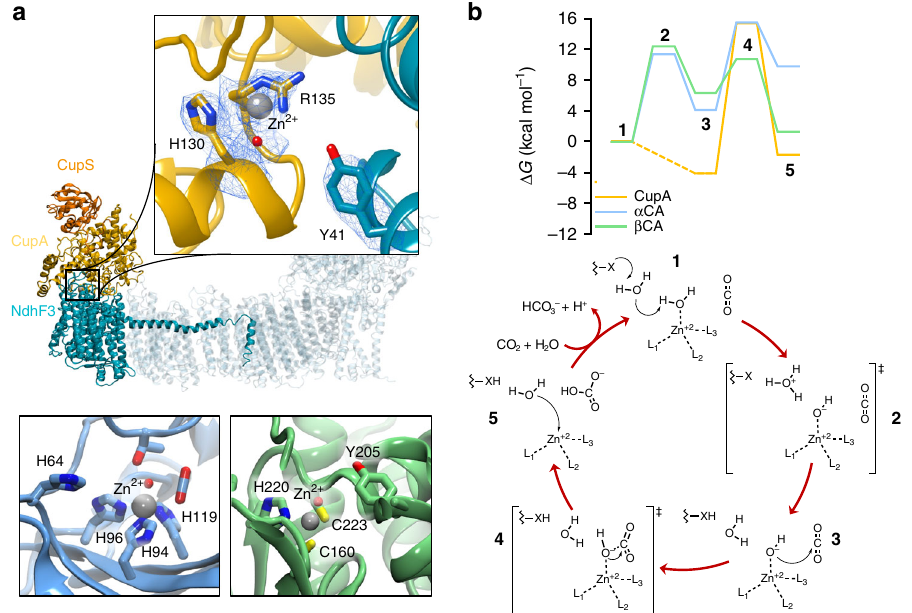
Fig. 2 Structural comparison and mechanism of carbon concentration in CupA and canonical carbonic anhydrases. a The active site structure of the CO 2 concentrating CupA subunit, showing the density of Zn-coordinating residues (5.5 sigma value, contour level 2, top), α -carbonic anhydrase ( α CA, PDB ID: 5YUI, bottom left), and β -carbonic anhydrase ( β CA, PDB ID: 1EKJ, bottom right). The Zn-bound density has been modelled as a water ligand, although the character of the ligand cannot be unambiguously assigned based on the map. b Reaction mechanism and free energy pro fi les for the CO 2 hydration process based on quantum chemical DFT models in CupA, α CA, and β CA with Tyr41, His64, and Tyr205 as proton acceptors, respectively. Free energies are reported at the B3LYP-D3/def2-TZVP/def2-SVP/ ε = 4 theory level (see Methods). Ligands L 1/2/3 = His130/Arg135/H 2 O, L 4 = H 2 O/OH − , X = Tyr41 in CupA; L 1/2/3 = His94/96/119, L 4 = H 2 O/OH − , X = His64 in α CA; L 1/2/3 = Cys160/223/His220, L 4 = H 2 O/OH − , X = Tyr205 in β CA. The CupA reaction takes place via two water molecules, modelled based on MD simulations (Supplementary Fig. 5j). See Supplementary Fig. 5 for further